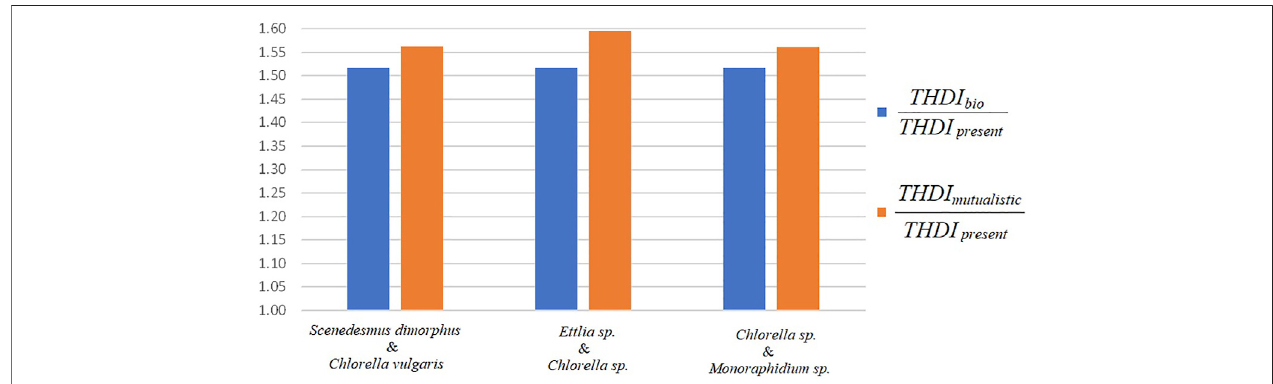
FIGURE1| TheItaliancase(2019data):ratiobetweenthe THDI valuesinthreedifferentcases: THDI present ,whichconsiderstheactualcarbondioxideemissionsof road transport; THDI bio , which considers the carbon dioxide emissions in the case of use of biodiesel from micro-organisms instead of the actual supply and THDI mutualistic , which considers the case of mutualistic biodiesel use.